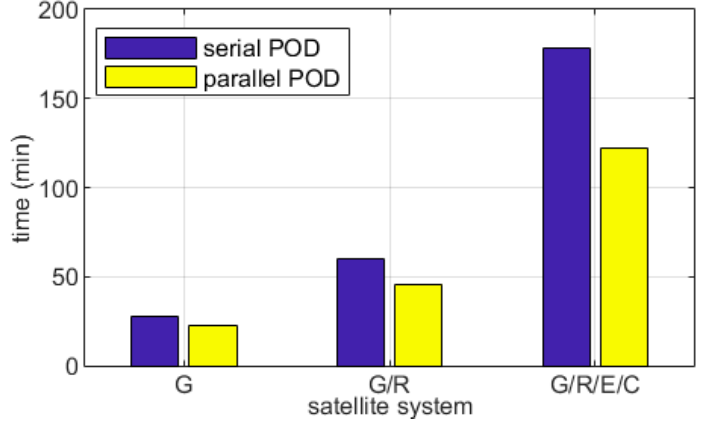
Figure 3. Computational time of parallel and non-parallel orbit determination.